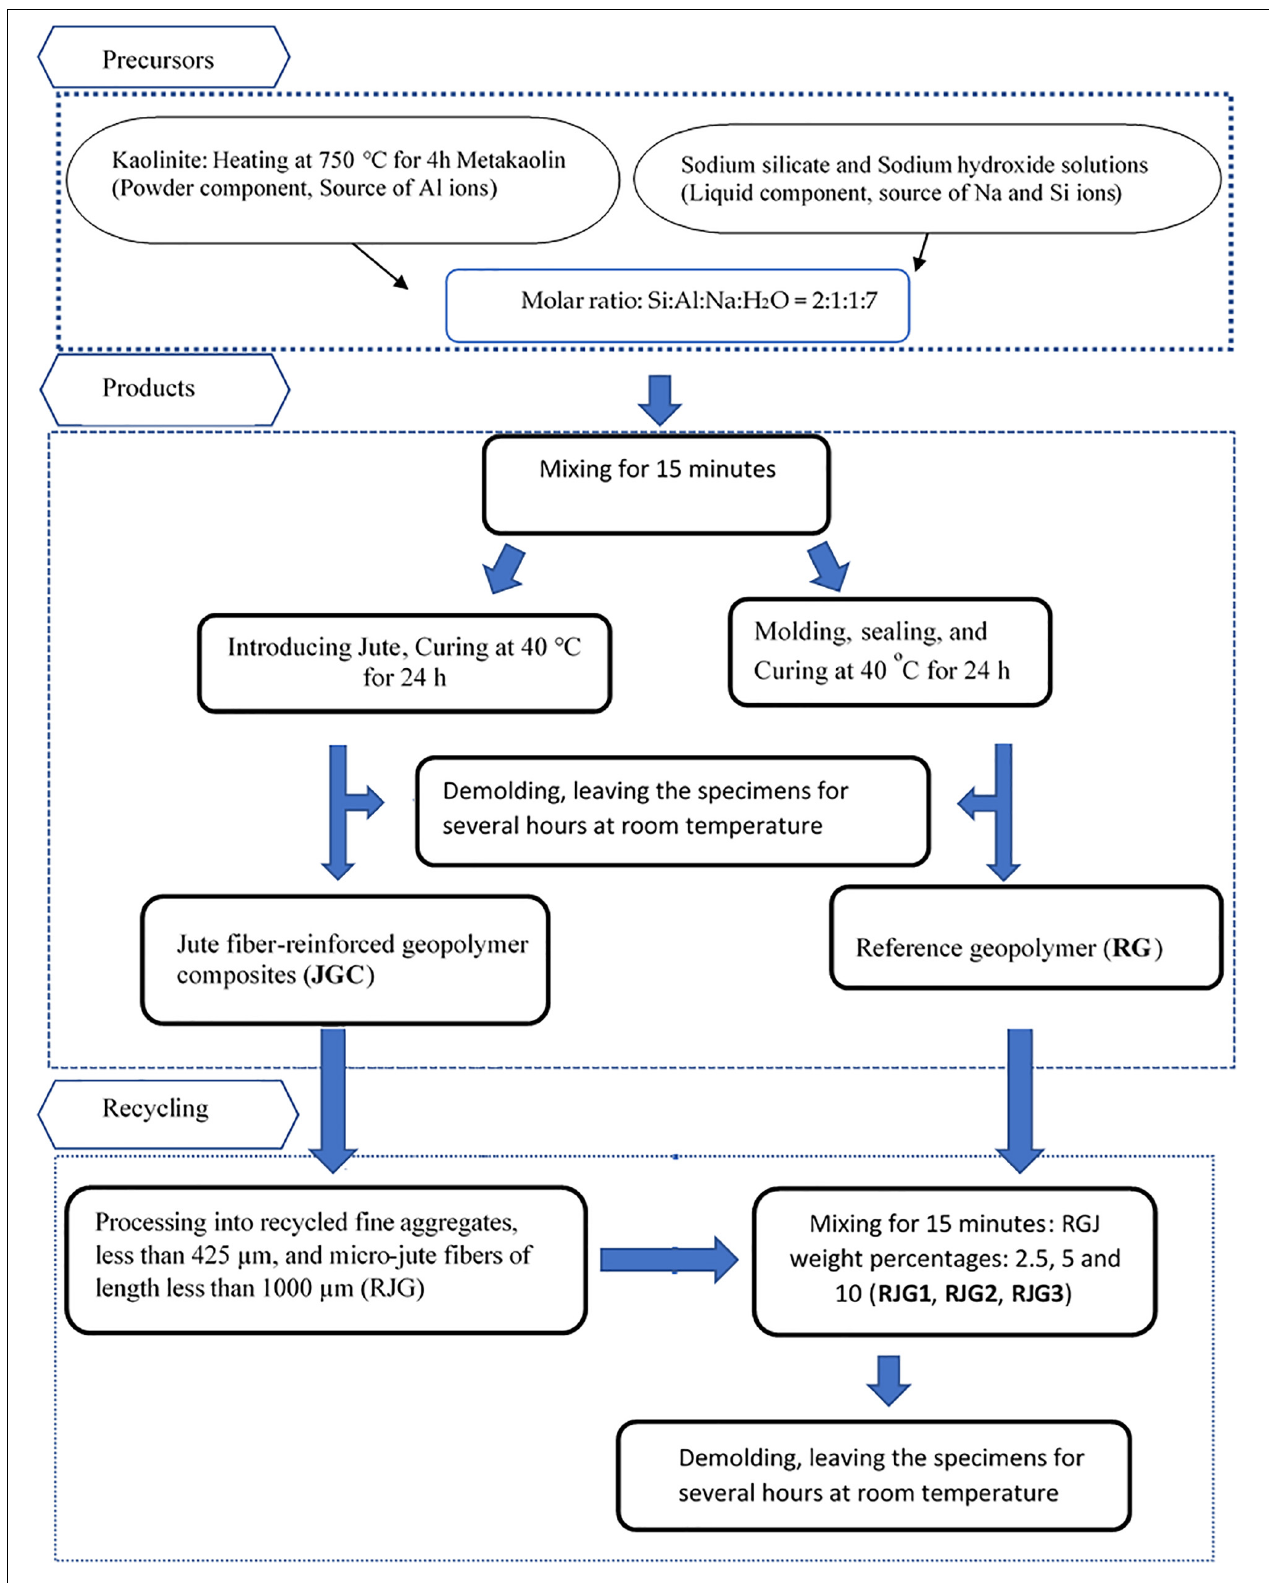
FIGURE 2 | Schematic diagram of the experimental design.